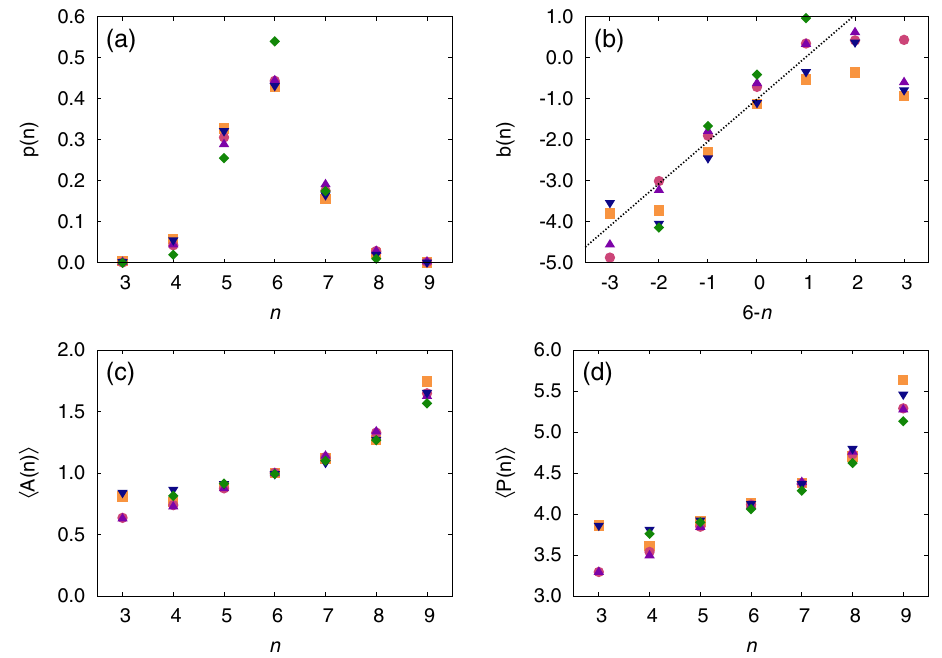
FIG. 10. Topological equivalence of tissues on different substrates. (a) Histogram of the number of neighbors per cell for each substrate. (b) Aboav-Weaire ’ s law for each substrate. The black line seen on the figure is a fit on the linear part of the data. (c) Lewis ’ law for each substrate. (d) Desh ’ s law for each substrate. The graphs consider tissues grown on all substrates: H glass (blue down-triangle), PL H 11 kPa gels (purple up-triangle), H 11 kPa gels (green diamonds), H 5 kPa gels (pink circle), and H 0.6 kPa gels (orange PL P PL PL squares). For the last two laws, the area A of each cell and its perimeter P have been divided by the cell mean area and its square root,